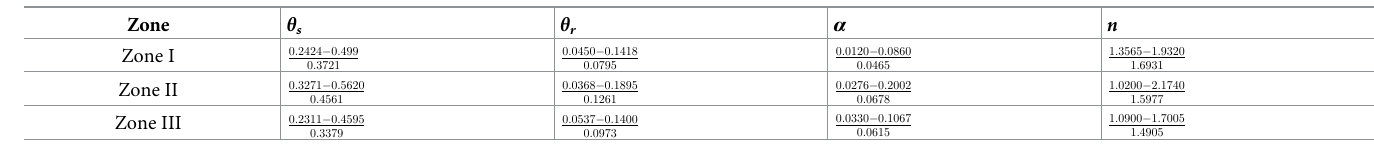
equation can be constructed to form a plane or more complex spatial surface in geometry to reflect the geological variable in space. Therefore, it separates the regional variation character- istics (trends) of environmental variables in space from the local variation characteristics (abnormalities). It can also remove the regional variation component and highlight the local variation component, to study the abnormal points and analyze their causes [71, 72]. Radial basis function method. Radial basis function (RBF) is a real-valued function whose value depends only on the distance from the origin [73], that is F x ð Þ ¼ φ k x kð Þ ð 2 Þ Or it can be the distance to any point c, where c is called the center point, that is F x ð Þ ¼ φ k x (cid:0) c kð Þ ð 3 Þ Any function Φ ( x ) that satisfies Eq (3) is called a radial basis function, and the distance is calculated by Euclidean distance [74, 75].